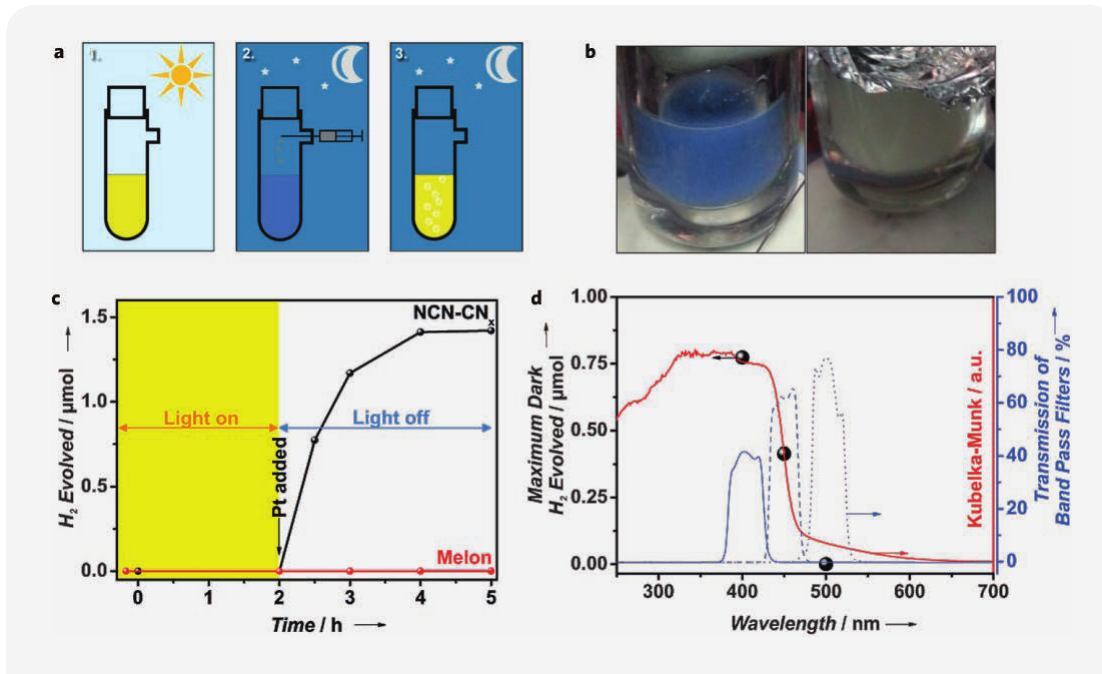
Figure 8. (a) Schematic representation of summary of the dark hydrogen evolution process. (b) Photographs of the “blue radical” (left) and its color reversal after the dark hydrogen evolution (right). (c) Plot representing the process of dark hydrogen evolution as a function of time. (d) Wavelength dependence of dark hydrogen evolved. Reproduced with permission from Ref.